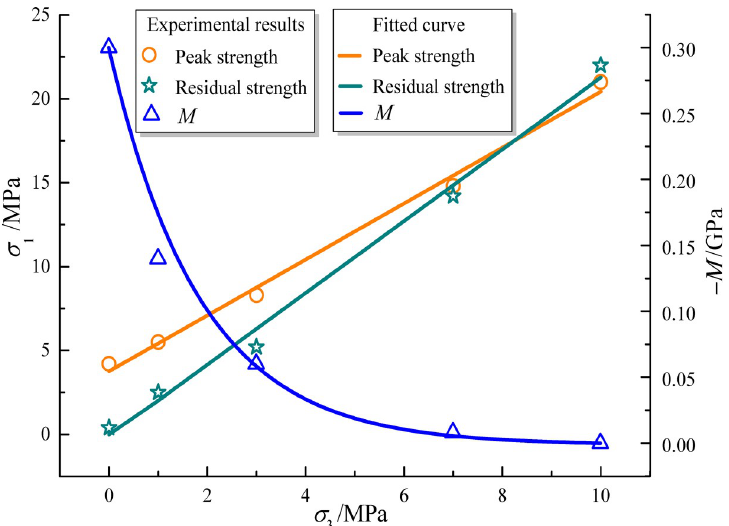
Fig 4. Fitted curves of mudstone strength and softening